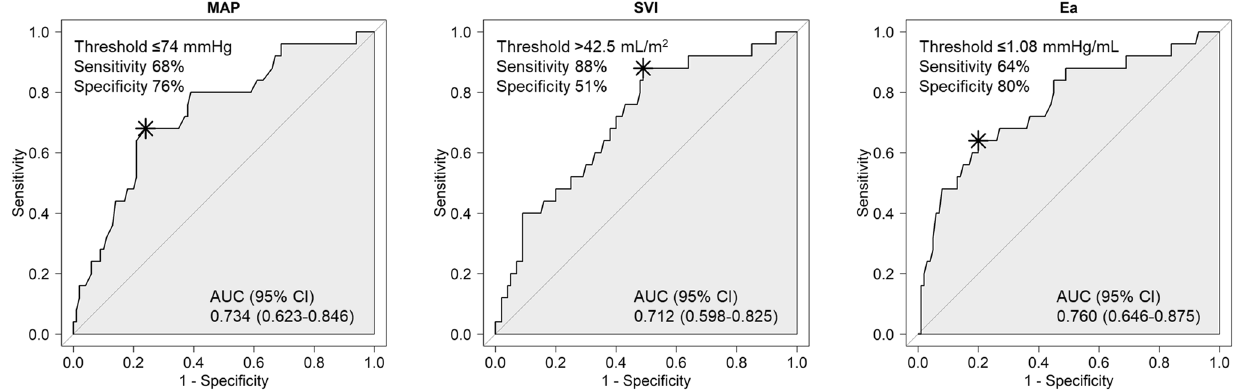
Figure 2. Areas under the receiver operating characteristics curves (AUCs) of each index for predicting hypotension after postural change from the Trendelenburg position to the supine position. CI confidence interval; MAP mean arterial pressure; SVI stroke volume index; Ea arterial